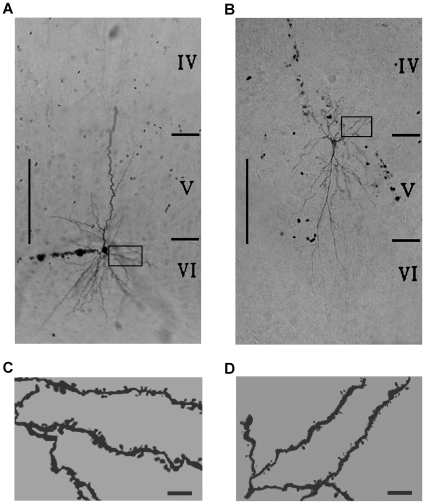
Differences in dendrite spines between F-ERF and S-ERF pyramidal neurons identified with DAB.(A) Image of an F-ERF neuron (SI = 0.23) in layer VI (number 17 in Table 1). (B) Image of an S-ERF neuron (SI = −0.62), which was an inverted pyramidal cell in layer V (number 35 in Table 1). (C) High magnification of a fraction of basal dendrites of the neuron in A (indicated by the rectangle in A) showing that the majority of spines for F-ERF neurons have a thicker and shorter neck with a larger head. (D) High magnification of dendrites of the neuron in B (indicated by the rectangle in B) illustrating that the majority of spines for S-ERF neurons are characterized by a thinner and longer neck with a small head. Roman numerals on the right in A and B indicate the cortical layers. Scale bar in A and B: 300 µm, and in C and D: 5 µm (not adjusted for shrinkage).